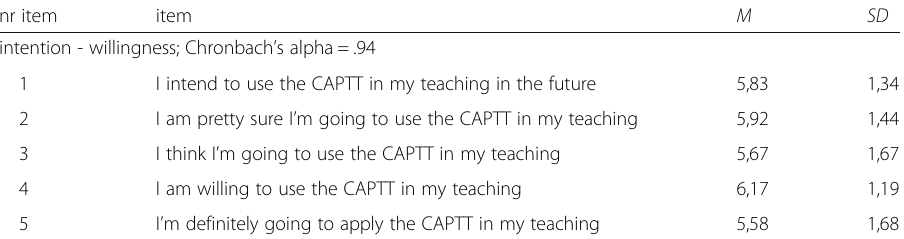
Table 7 Behavioural intention measure nr item